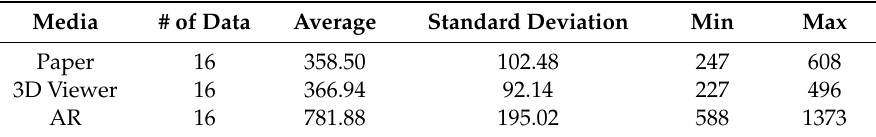
Table 2. Experimental result of total assembly time in seconds.